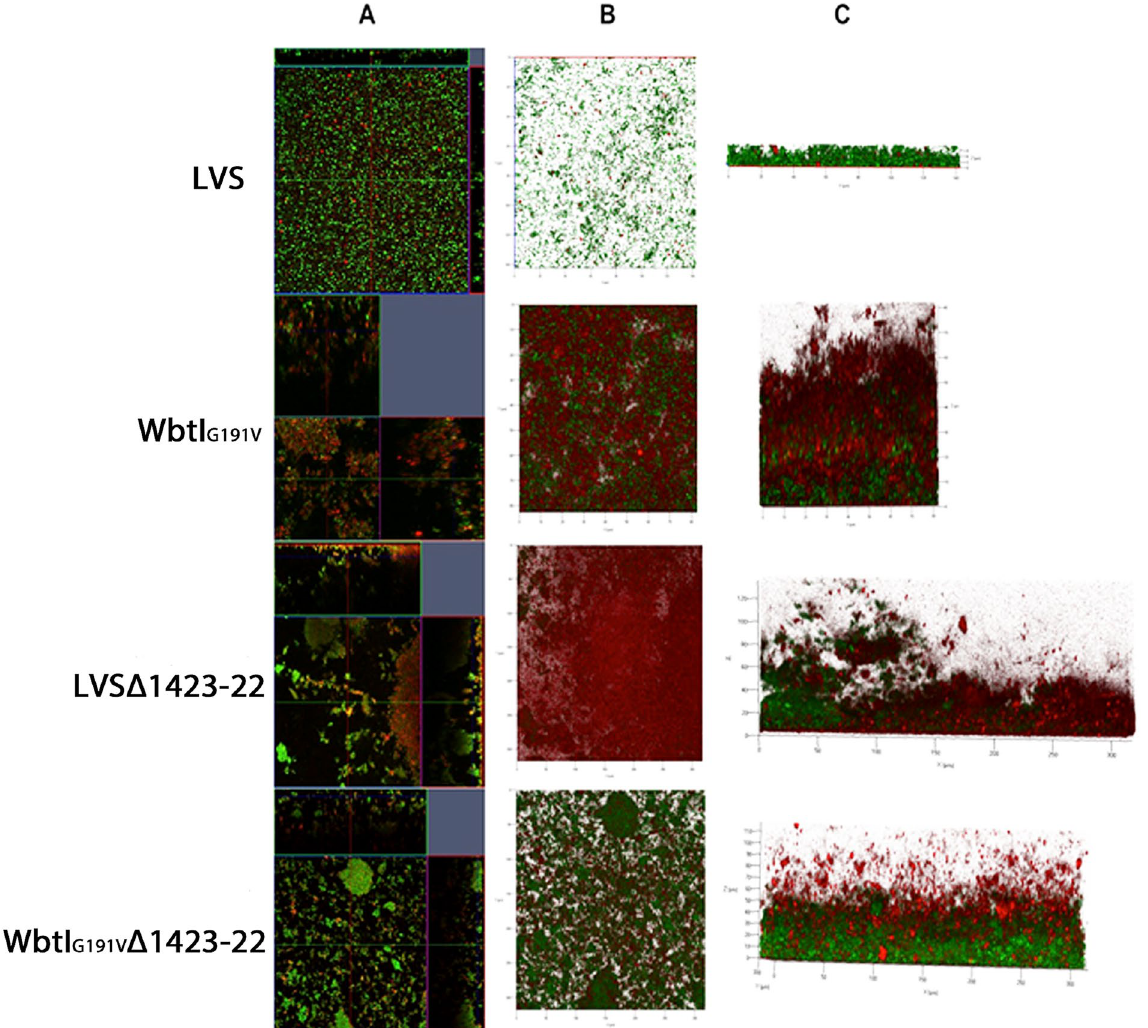
Figure 5. Comparison of biofilm matrix development by F . tularensis LVS and its surface structure mutants by CLSM. Panel (A) shows orthogonal sections of horizontal (z) and side views (x and y) of reconstructed three- dimensional biofilm images at a magnification of 25x. Nucleic acids were stained with Syto9 (green) and the matrix EPS stained with Texas Red-ConA (red). Panel (B) is an overview (x and y) view of the reconstructed three-dimensional z-stack of each biofilm growth on the coverslip. Panel C is the side view of the three- dimensional z-stack. Each picture was obtained from biofilms grown for 15